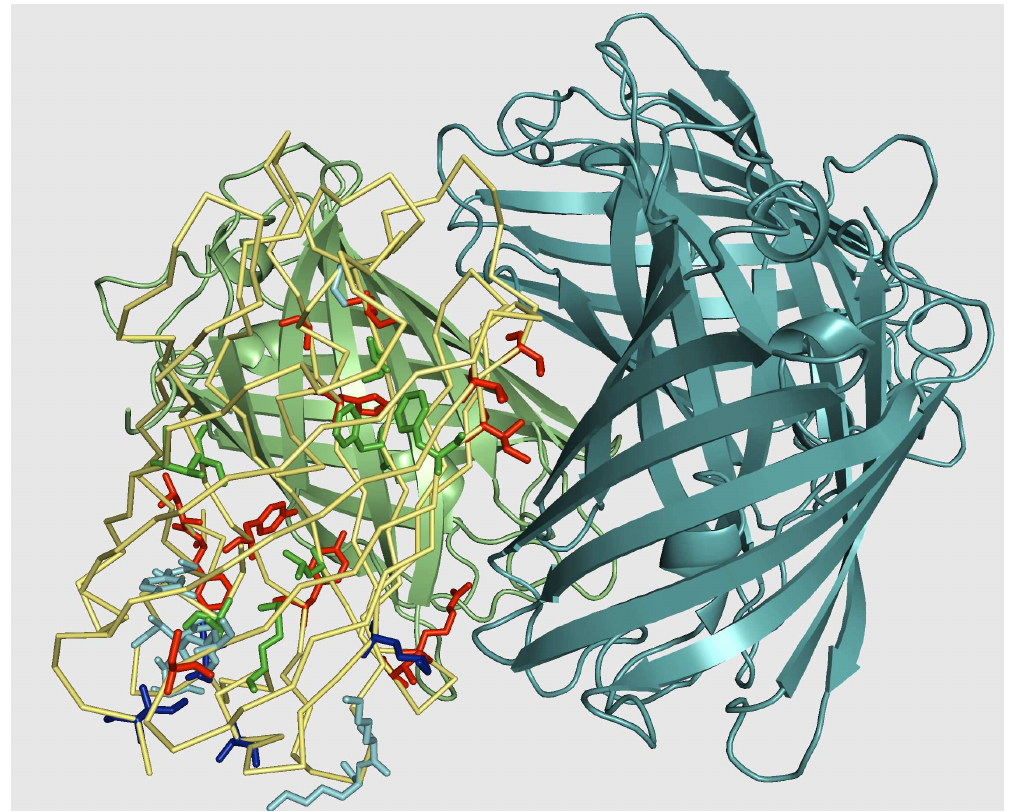
Figure 1. DsRed tetramer (1GGX). Residues relevant for the multimeric properties are shown explicitly, and colored according to the score as in Table 5. The tetramerization is here schematized as “dimerization of dimers” ( dimer in